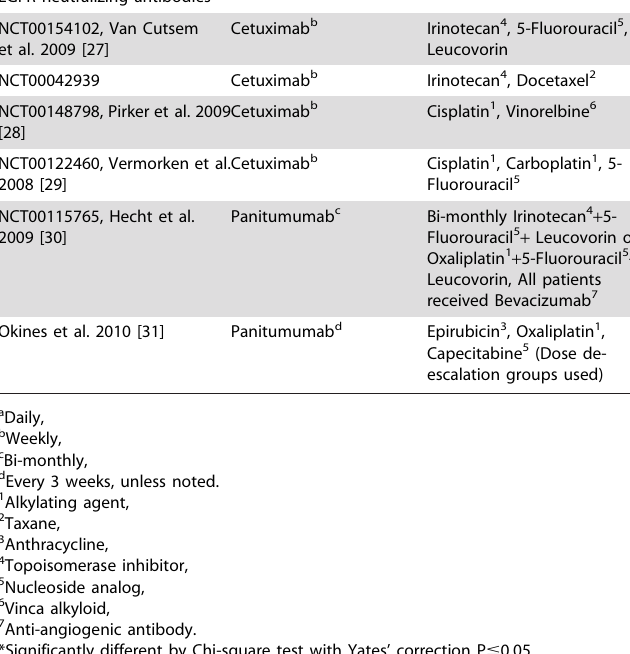
levels of proliferation as indicated by BrDU (Figure 6D, arrow- heads) and PCNA (Figure 6E, arrowheads) immunofluorescence but inhibitor treated mice had fewer p53-positive cells at 3d post- cyclophosphamide (Figure 6F). Thus, EGFR inhibitors adminis- tered prior to cyclophosphamide provided partial protection from